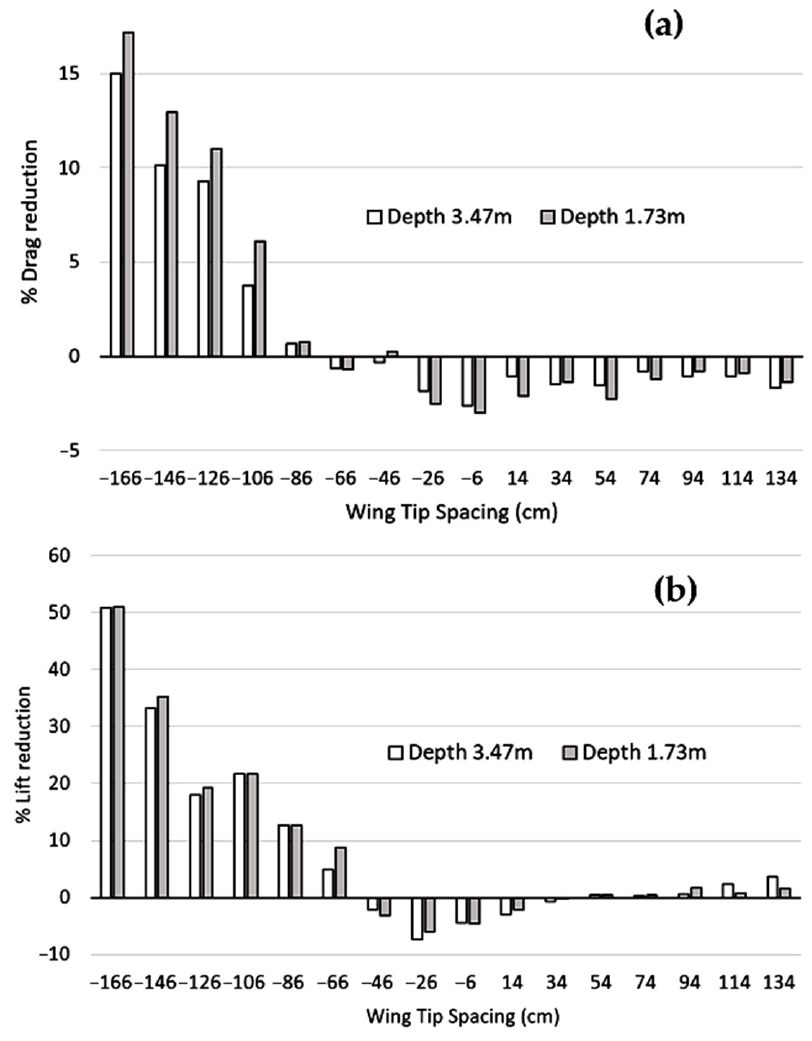
Figure 4. Reduction or increase (in %) in drag ( a ) and lift ( b ) of bird 2, compared to bird alone, as a function of distance between birds (Wing Tip Spacing and Depth).